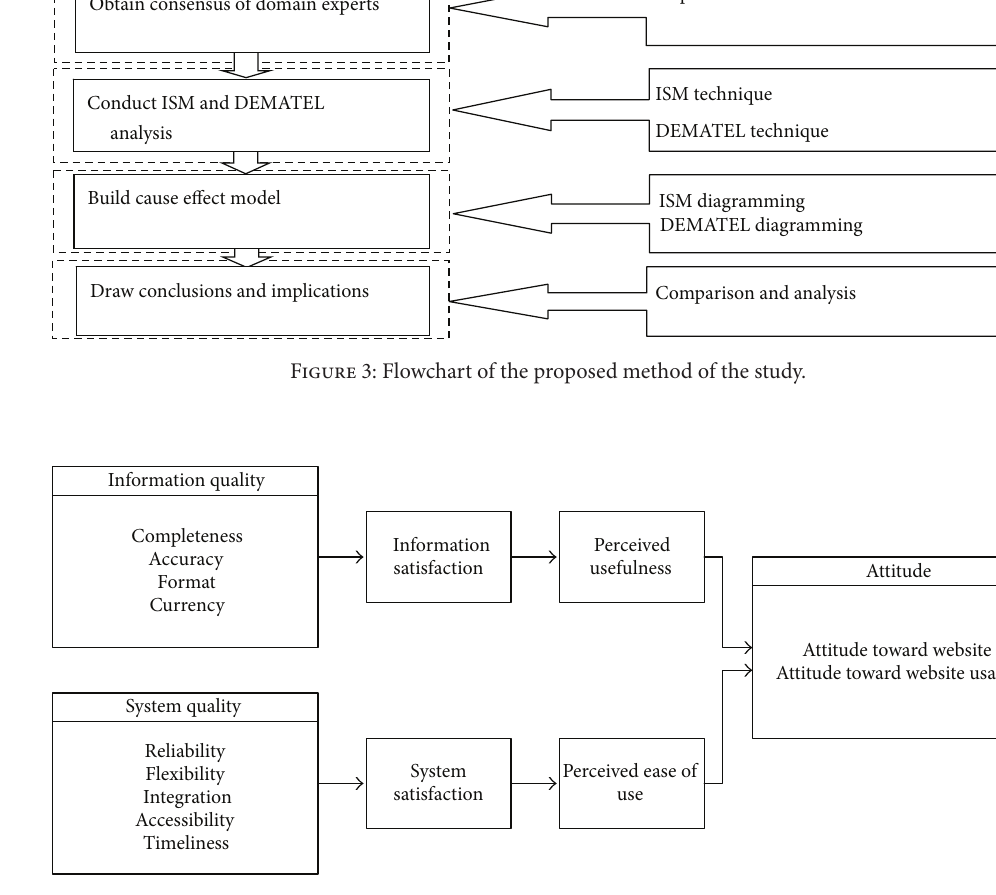
Figure 4: The structure of proposed model